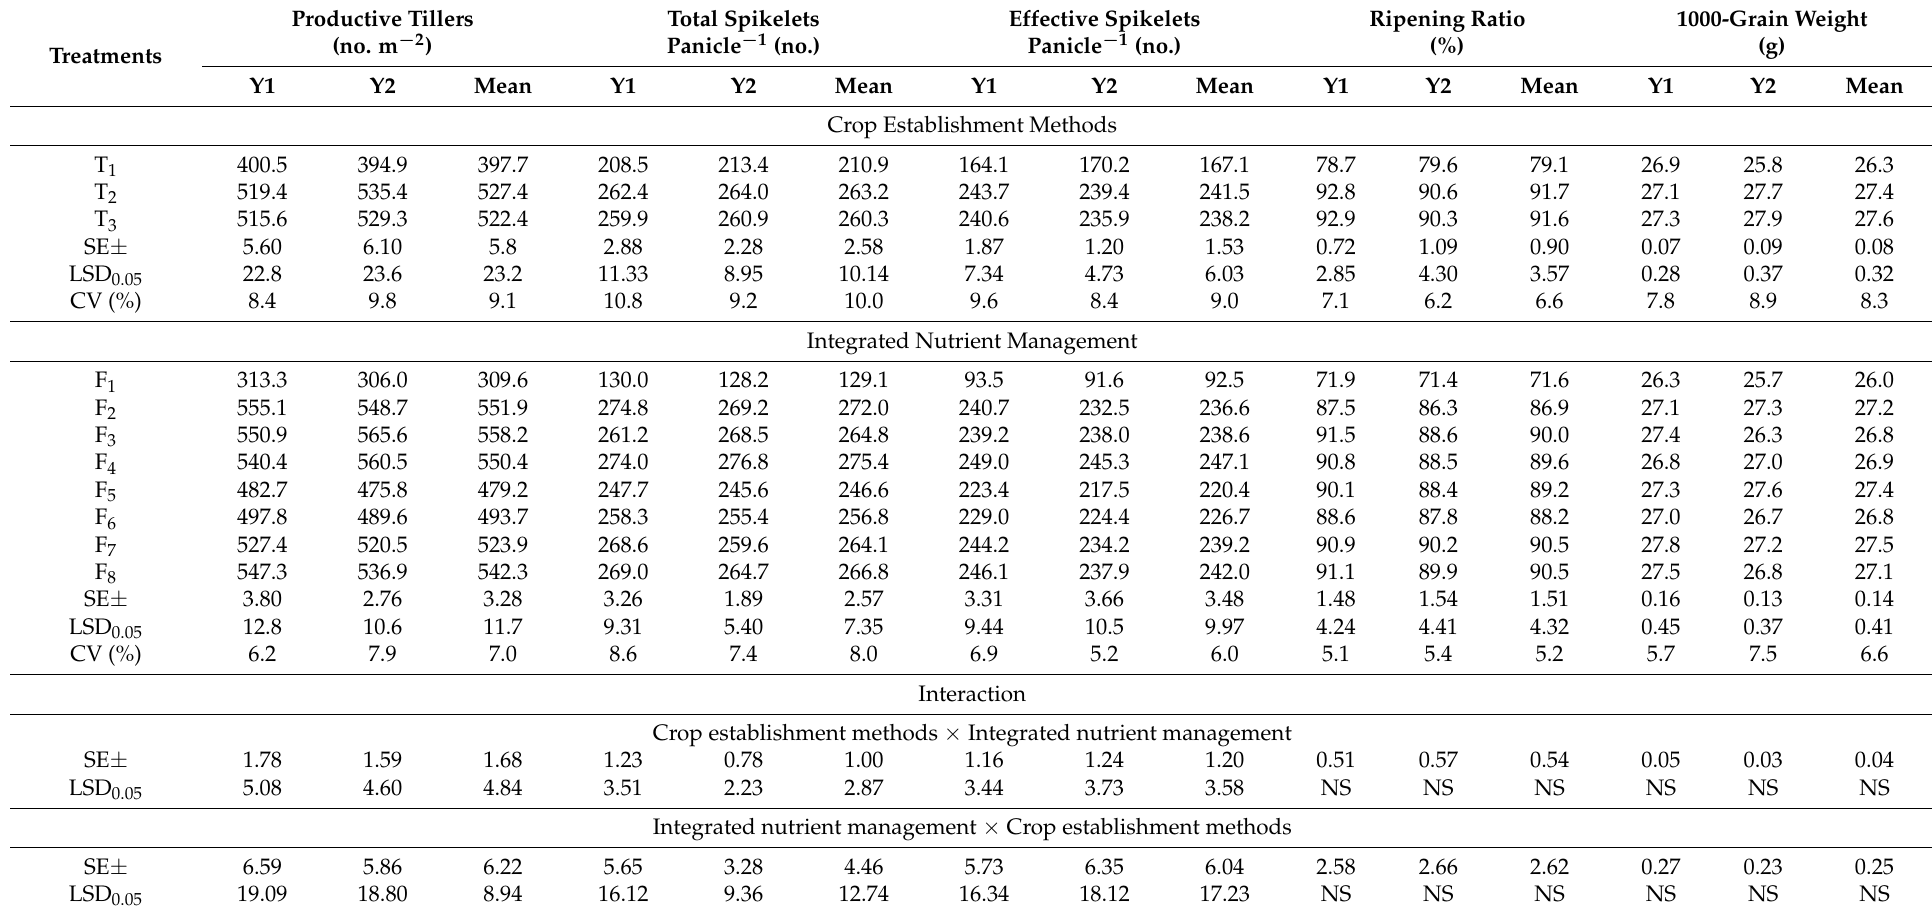
Table 3. Crop establishment methods and integrated nutrient management influenced the yield attributes of